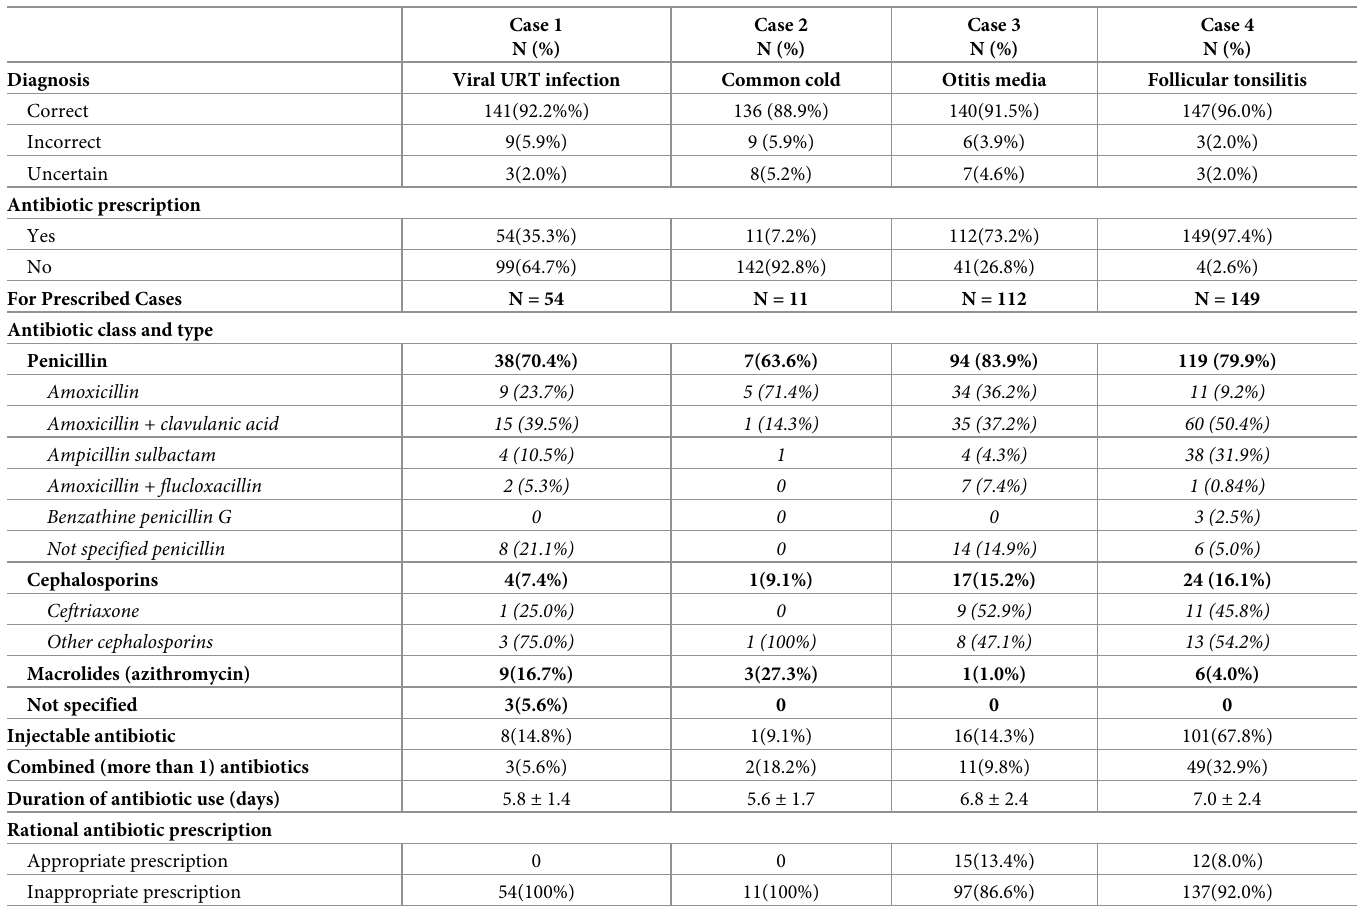
Table 4. Participants’ responses to clinical